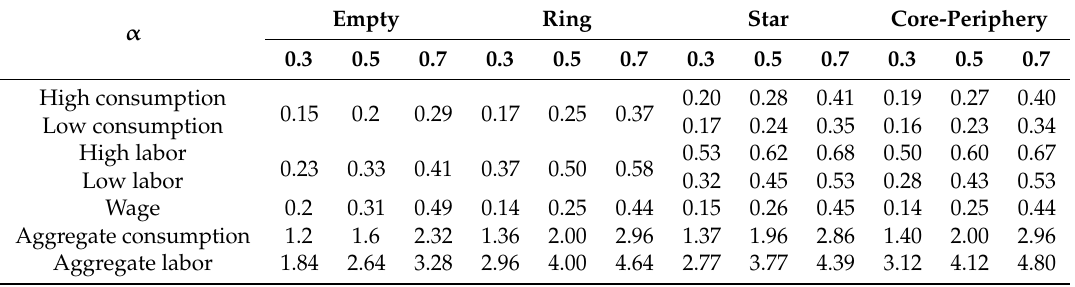
Table 1. Equilibrium outcomes under four types of networks and three technology environments ( S ( n i ) = n i ). Empty Ring α